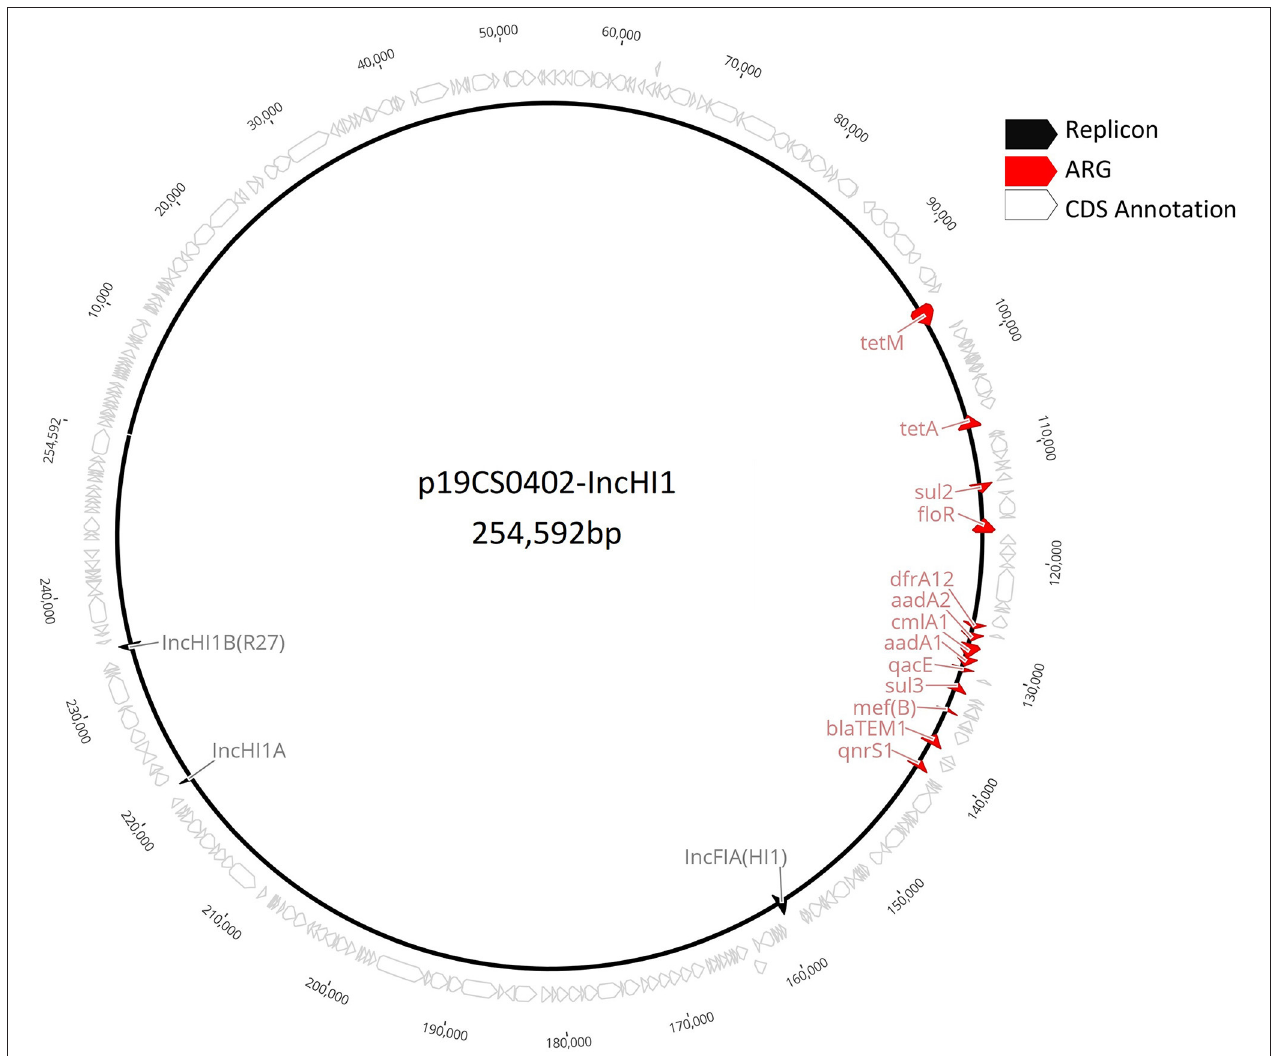
FIGURE 1 | Complete plasmid sequence of p19CS0402-IncHI1 from the Vietnamese strain 19CS402.